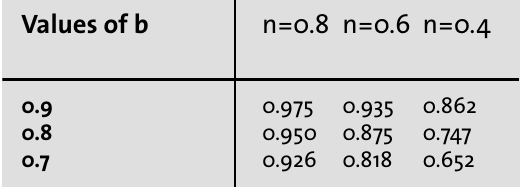
Table 2: Viscosity correction factors for non-Newtonian liquids measured in wide- gap concentric cylinder vis-